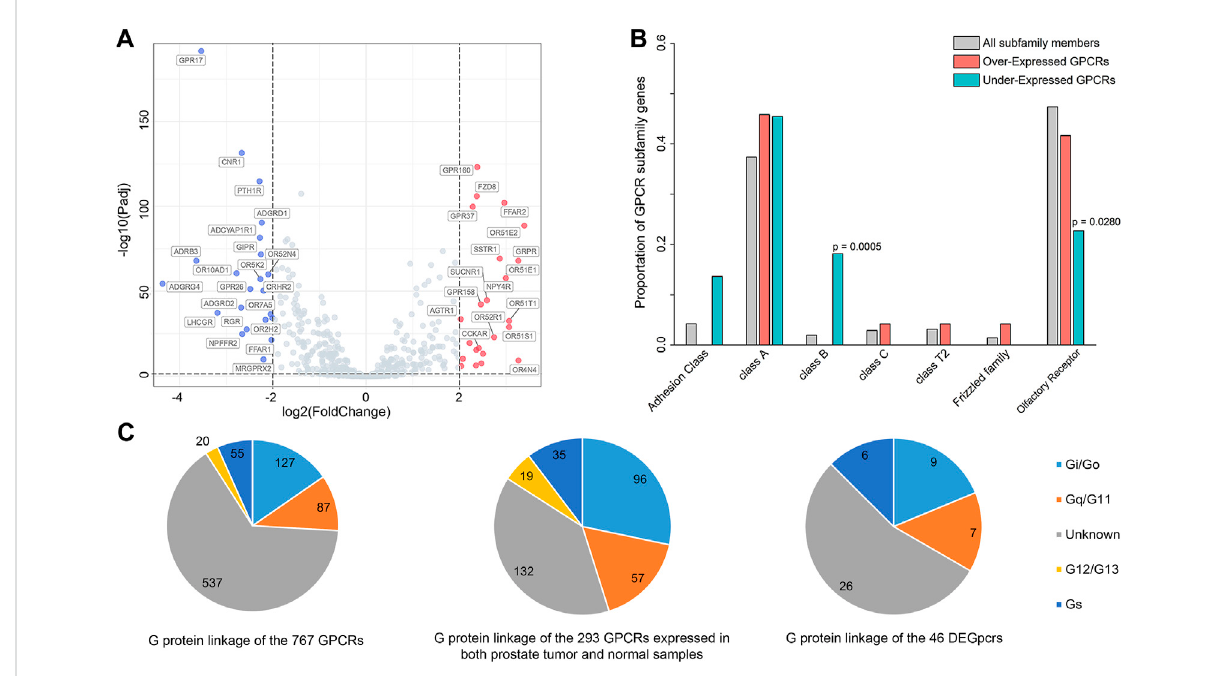
FIGURE 1 Differentially expressed GPCRs (DEGpcrs) between 495 primary prostate tumor samplesand 151 normal samples. (A) Volcano plotshowing the DEGpcrs. Red and blue dots represent the signi fi cantly up- and downregulated genes, respectively. (B) Barplot showing subfamily distributionof the DEGpcrs. (C) G protein linkage of all the 767 GPCRs (right), the 293 GPCRs expressed in both prostate tumor and normal samples (middle), and the 46 DEGpcrs